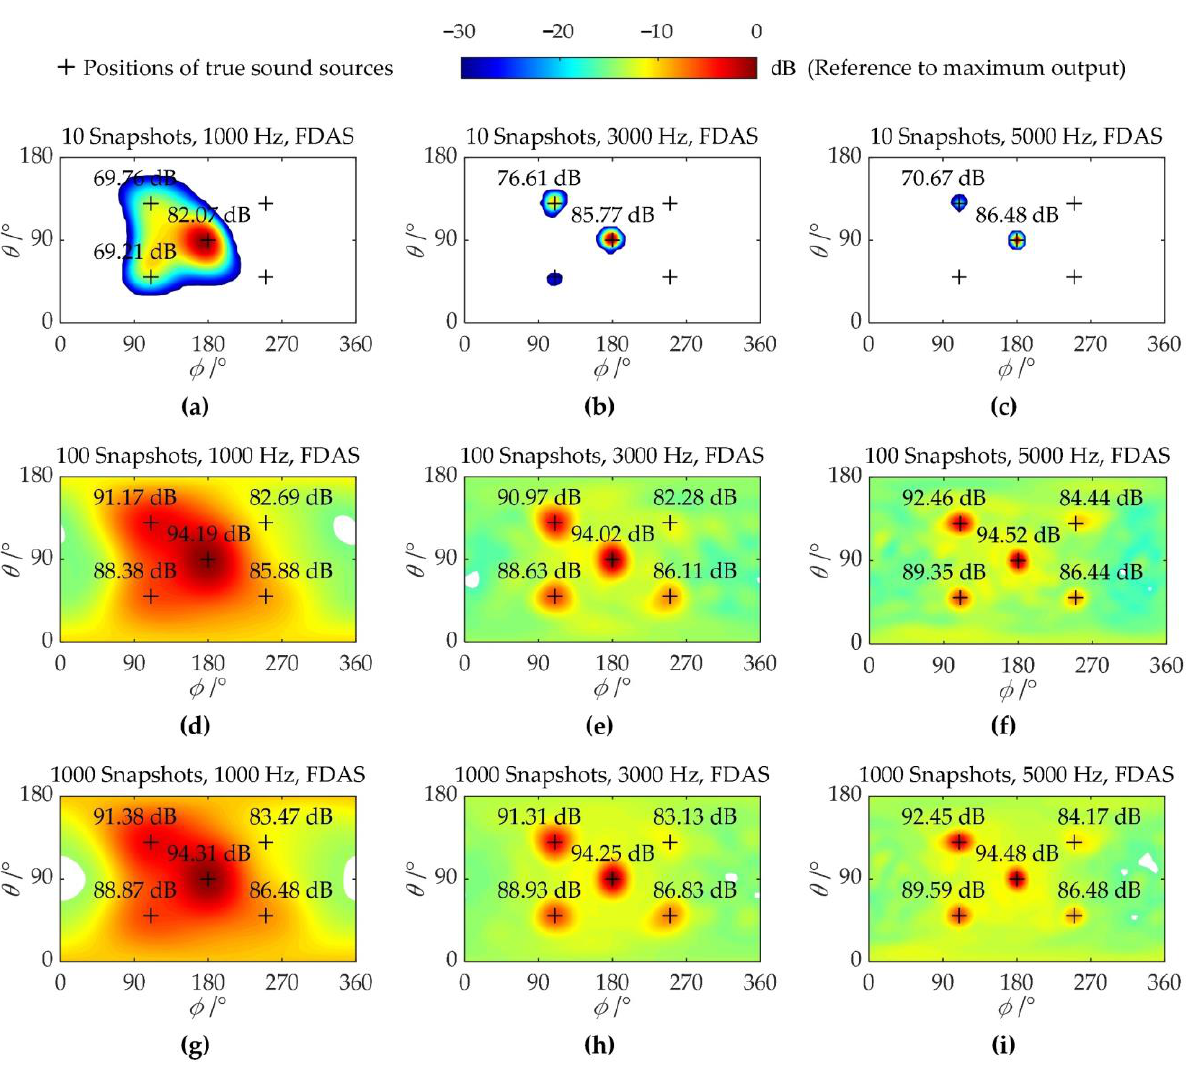
Figure 3. Colormaps of FDAS with SNR = 0 dB and different snapshots: ( a – c ) Maps of FDAS with 10 snapshots at 1000 Hz, 3000 Hz, and 5000 Hz, respectively; ( d – f ) Maps of FDAS with 100 snapshots at 1000 Hz, 3000 Hz, and 5000 Hz, respectively; ( g – i ) Maps of FDAS with 1000 snapshots at 1000 Hz, 3000 Hz, and 5000 Hz, respectively.